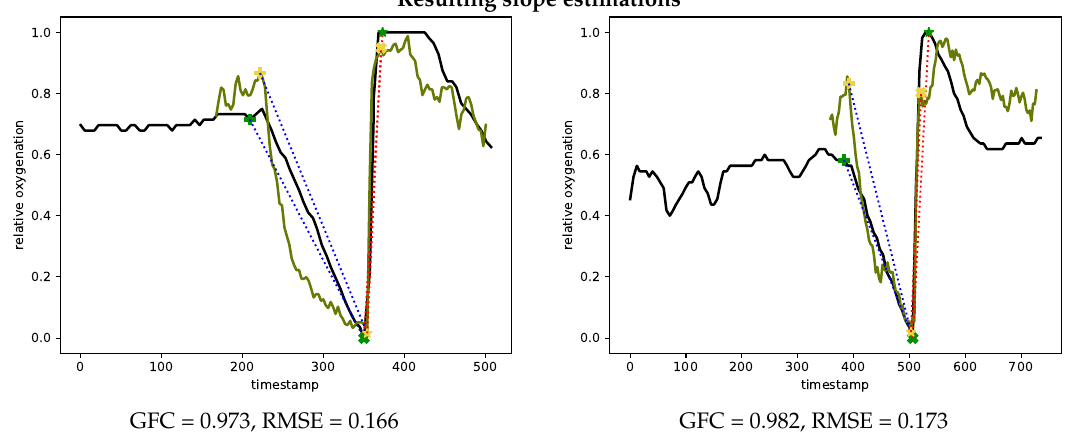
Figure 15. Representative oxygenation curves from the INVOS system (black) and estimates from the spectral filter array system (green). Linear desaturation (blue dots) between baseline (+) and low point of oxygenation (x (SFA) and * (INVOS)). Linear resaturation (red dots) between low point (x (SFA) and * (INVOS)) and high point (x (SFA) and * (INVOS)) of oxygenation. Representative curves with median GFC ( left , #V46-2) and median RMSE ( right , #V01-1) metrics. Desaturation correlation = 0.750